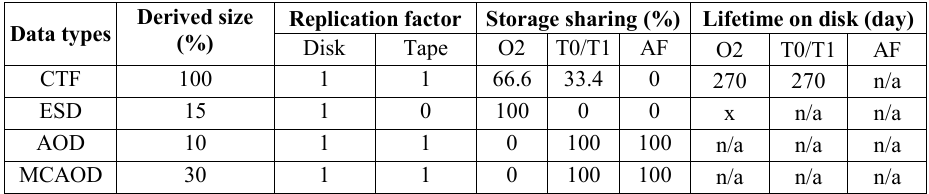
Table 3. Data types, replication factors, storage sharing and lifetime for Pb-Pb collisions.